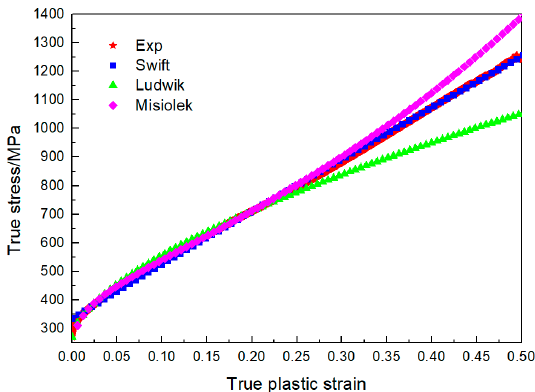
Figure 2. Fitting results of different flow stress mathematical models. Table 2. Calibration results of different flow stress mathematical models.